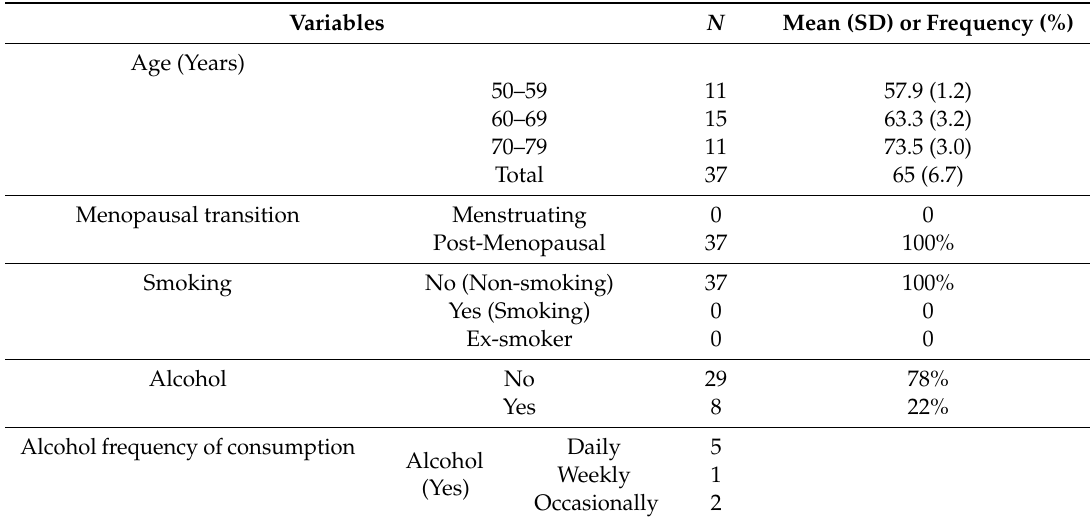
Table 1. Clinical characteristics at baseline of the 37 subjects involved in the